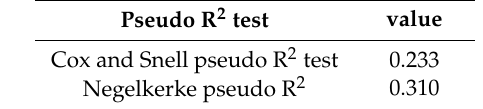
Table 8. Results of the Cox and Snell pseudo R 2 test and the Negelkerke pseudo R 2 test.